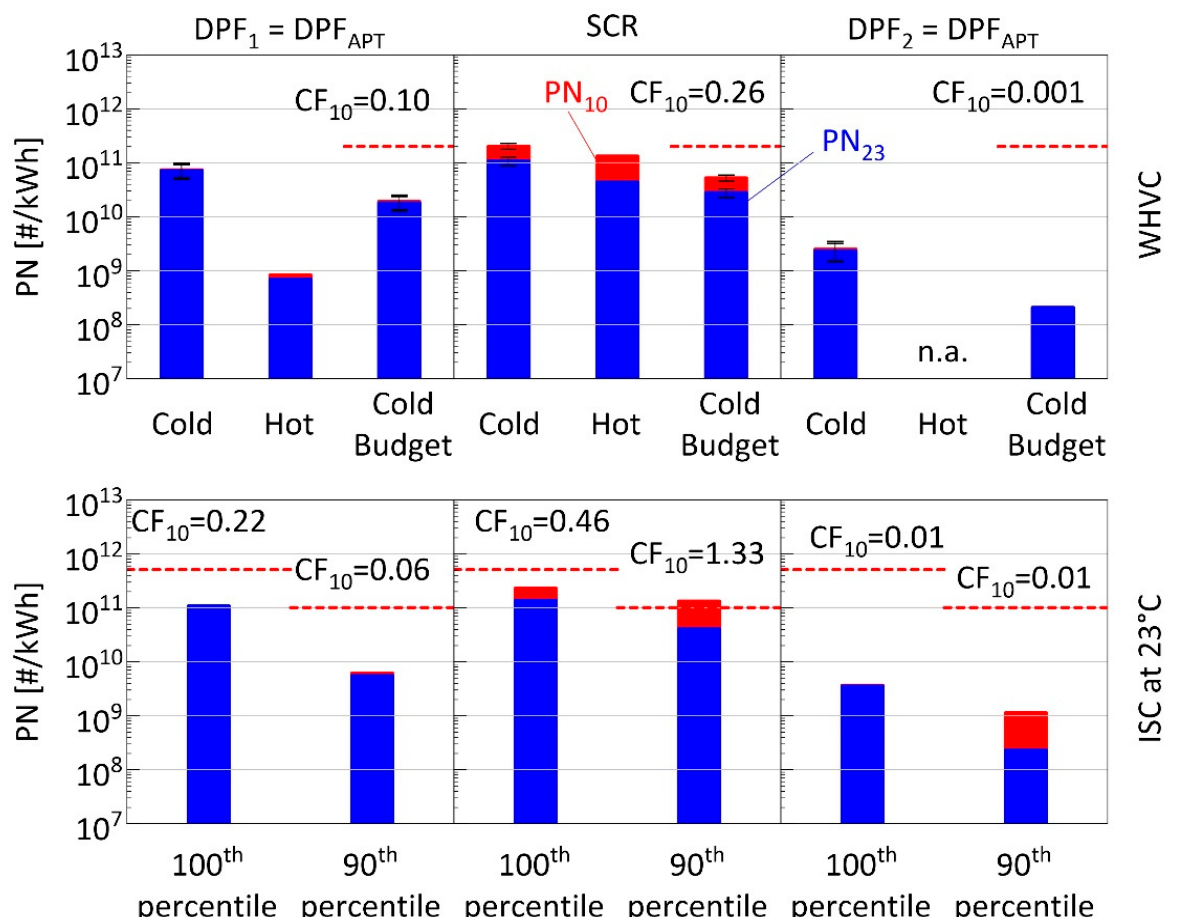
Figure 5. Summary of Particle Number (PN) emissions following what has been proposed as post Euro VI evaluation methodology, for the tests where the DPF APT filter was used in DPF 1 position. Charts on the left, middle and right planes correspond to emission levels at DPF 1 out, SCR and DPF 2 out positions, respectively. Charts on the top and bottom planes correspond to WHVC and ISC at 23 ◦ C tests, respectively. Blue bars correspond to SPN 23 while red bars correspond to SPN 10 . The error- bars indicate the maximum and minimum emissions, while the dashed lines indicate the proposed limits (2 × 10 11 #/kWh for budget, 5 × 10 11 #/kWh for 100th percentile, and 1 × 10 11 #/kWh for 90th percentile), while the numbers on top represent the conformity factor (ratio of average emissions over applicable limit). APT = Accelerated Purification Technology; cDPF = Catalyzed DPF; CF = Conformity Factor; DPF = Diesel Particulate Filter; ISC = In-Service Conformity Cycle; OEM = Original Equipment Manufacturer; SCR = Selective Catalytic Reduction; WHVC = Worldwide Harmonized Vehicle